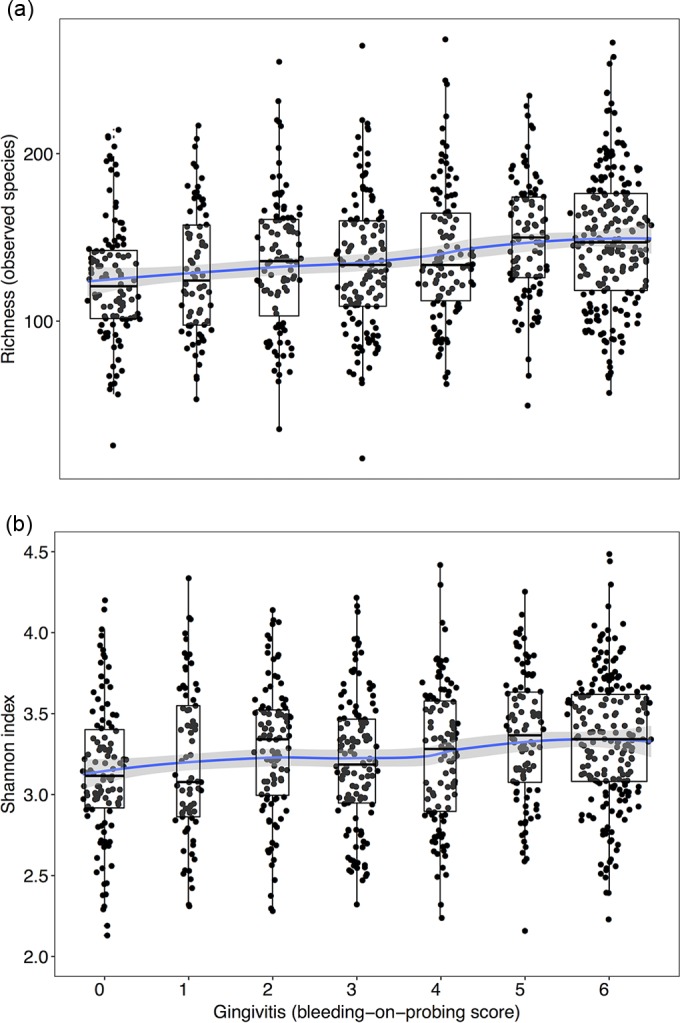
Microbial community richness and Shannon index increase with gingivitis severity. Both richness (number of observed species) (a) and Shannon index (measure of diversity) (b) of supragingival plaque increase with gingivitis severity. Estimates for each sample were calculated by sampling with replacement at a rarefaction depth of 5,000 sequences per sample and averaging over 100 iterations. The fitted line shows a local polynomial regression fit calculated using loess in R, with the gray region indicating the 95% CI. A total of 138/965 samples were excluded due to having fewer than 5,000 sequences. Changing the rarefaction depth did not affect the conclusion that gingivitis severity was associated with an increase in both species richness and Shannon index.